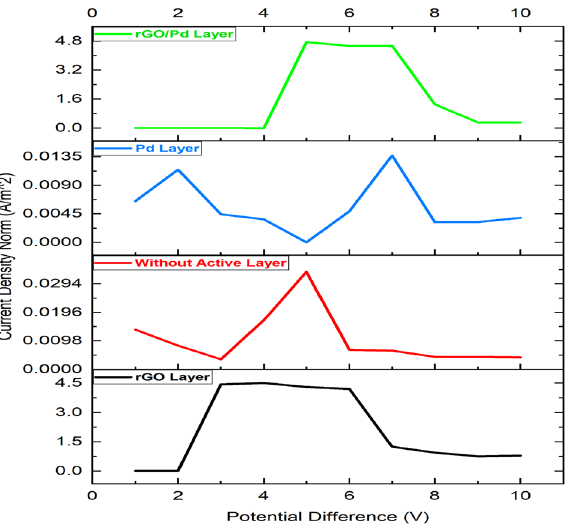
Figure 7. V–I response of Chemical gas sensor with and without active layers i.e., SnO 2 thin film, SnO 2 – Pd, SnO 2 –rGO & SnO 2 –Pd/rGO.